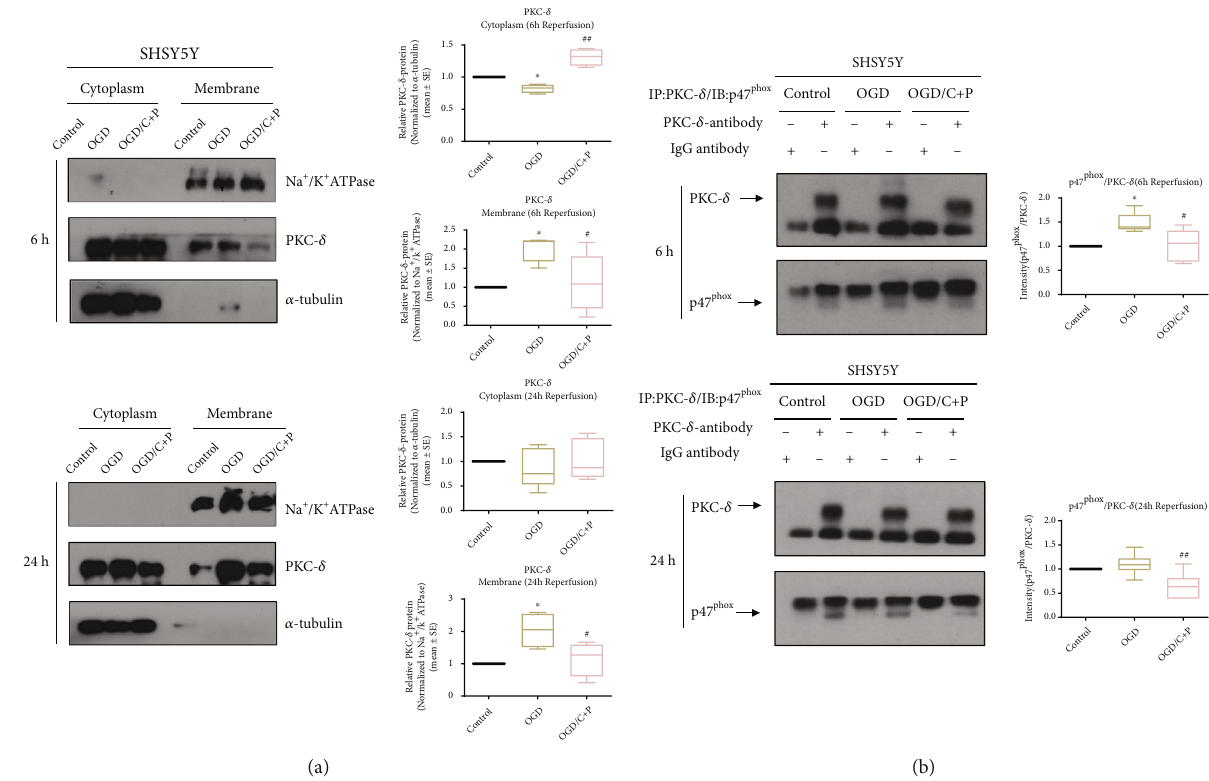
Figure 6: C+P suppressed the translocation of PKC- δ and interaction of PKC- δ with p47 phox induced by OGD/R in SHSY5Y cells. (a) Representative bands of cytosolic and membrane PKC- δ identi fi ed using Western blot at 6 and 24 hours of reperfusion. Bar graphs show semiquantitative PKC- δ levels in the cytosol and membrane determined using band density analysis. Cytosolic PKC- δ expression decreased but increased in the membrane in the OGD/R group at 6 hours after reoxygenation as compared to the control group. Administration of C+P negated the changes of OGD/R-induced PKC- δ expression. No di ff erences were detected in cytosolic PKC- δ expression in the OGD/R group at 24 hours of reoxygenation, but OGD/R increased membranous PKC- δ expression as compared to the control group. C+P attenuated the raised cellular membrane PKC- δ concentration. ∗ p < 0 : 05 , as compared to the OGD group; # p < 0 : 05 , ## p < 0 : 01 , as compared to the OGD/C+P group. All the quanti fi cations were normalized to α -tubulin (cytosol) or Na + /K + ATPase (membrane), respectively. Results are shown as mean ± SE of three independent experiments. (b) Representative bands of coimmunoprecipitation of PKC- δ and p47 phox in SHSY5Y cells, identi fi ed via the Western blot technique at 6 and 24 hours of reoxygenation. Bar graphs show the ratios of p47 phox /PKC- δ identi fi ed using band density analysis. IgG antibody served as the control. In comparison to IgG control, a signi fi cant enhancement in p47 phox was detected in the immunoprecipitation complex with the PKC- δ antibody from cell lysates, which suggests a heightened interaction of PKC- δ and p47 phox . Moreover, the interaction of PKC- δ and p47 phox increases after 6 hours of reoxygenation, while C+P treatment reduced the interaction. Although the interaction between the control and the OGD group was not signi fi cant at 24 hours of reoxygenation, the interaction did increase, and C+P treatment lowered the interaction between PKC- δ and p47 phox . ∗ p < 0 : 05 versus the OGD group; # p < 0 : 05 , ## p < 0 : 01 versus the OGD/C+P group. The data is represented as mean ± SE of three independent